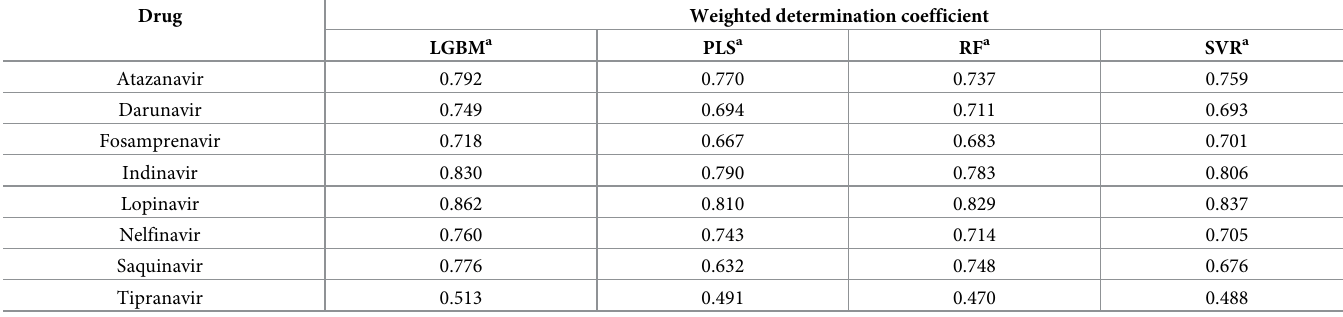
Table 2. Weighted determination coefficients for prediction in external test dataset ( R 2